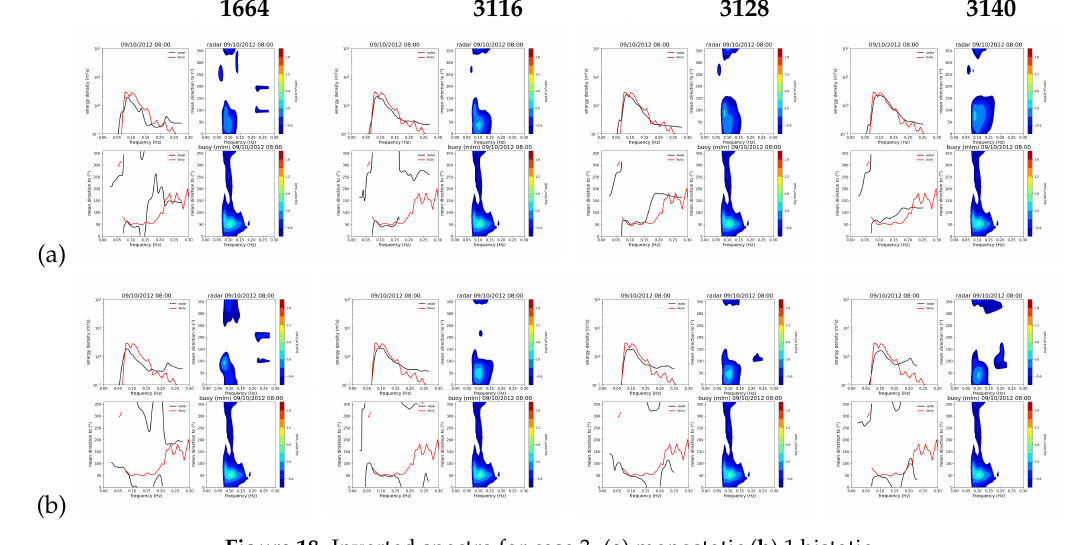
Figure 18. Inverted spectra for case 3. ( a ) monostatic ( b ) 1 bistatic.